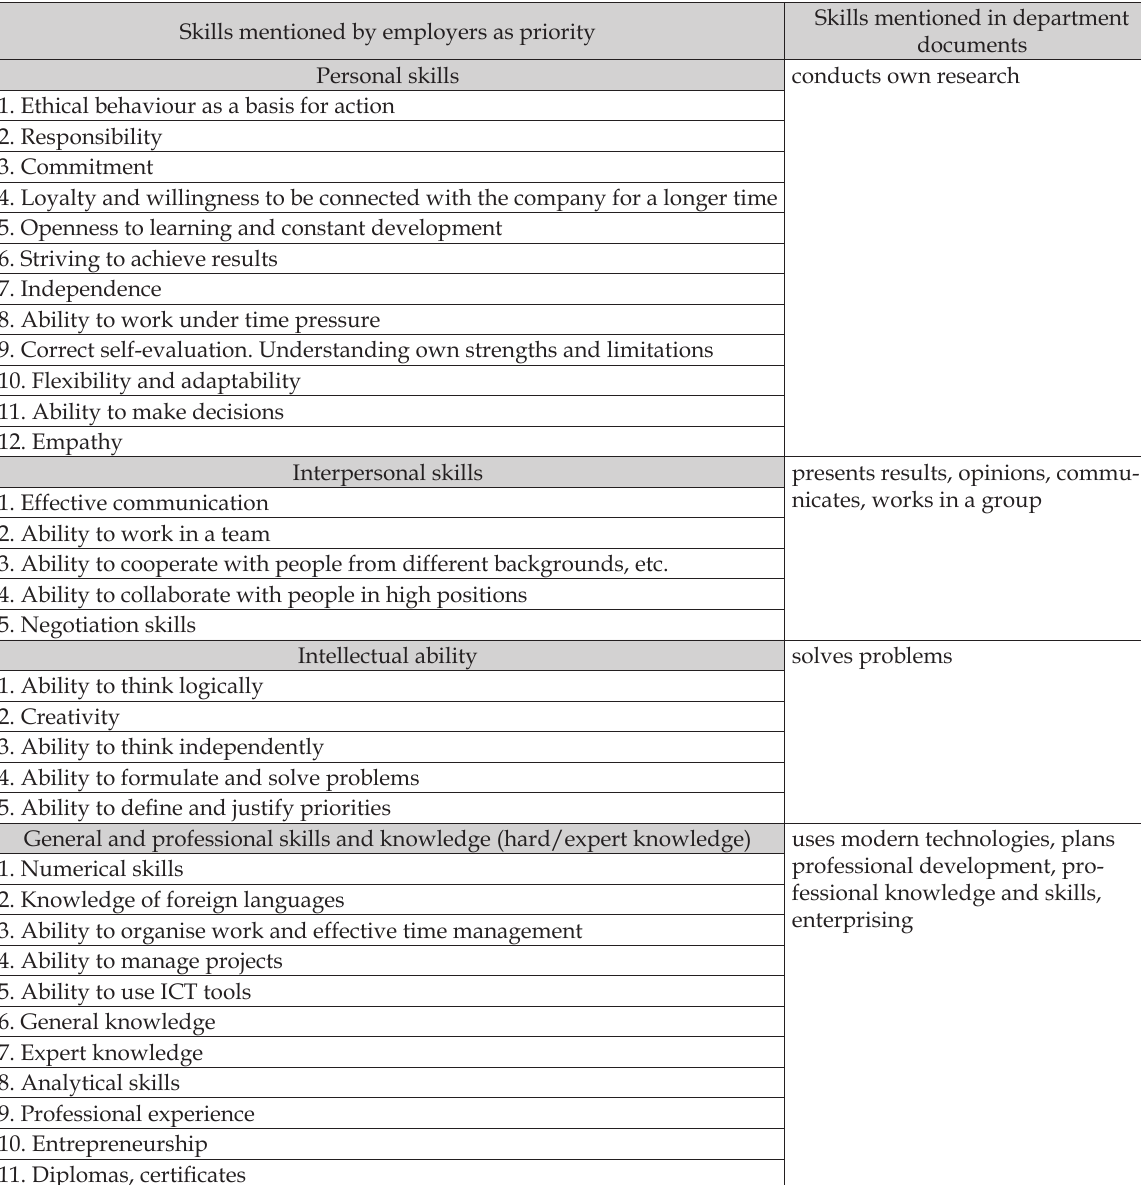
Table 3. List of skills mentioned by employers as priorities and skills mentioned in department documents. Skills mentioned by employers as